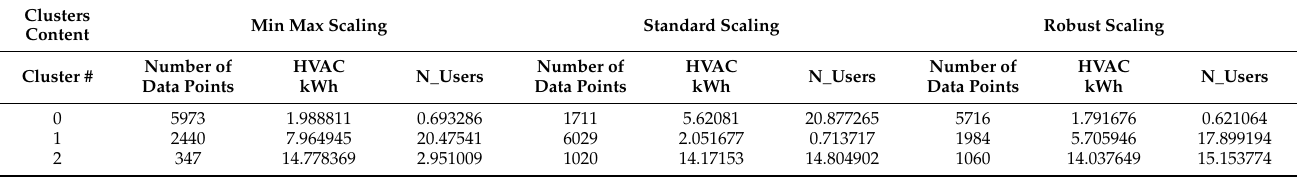
Table 9. Clustering the HVAC consumption and the number of users: results.